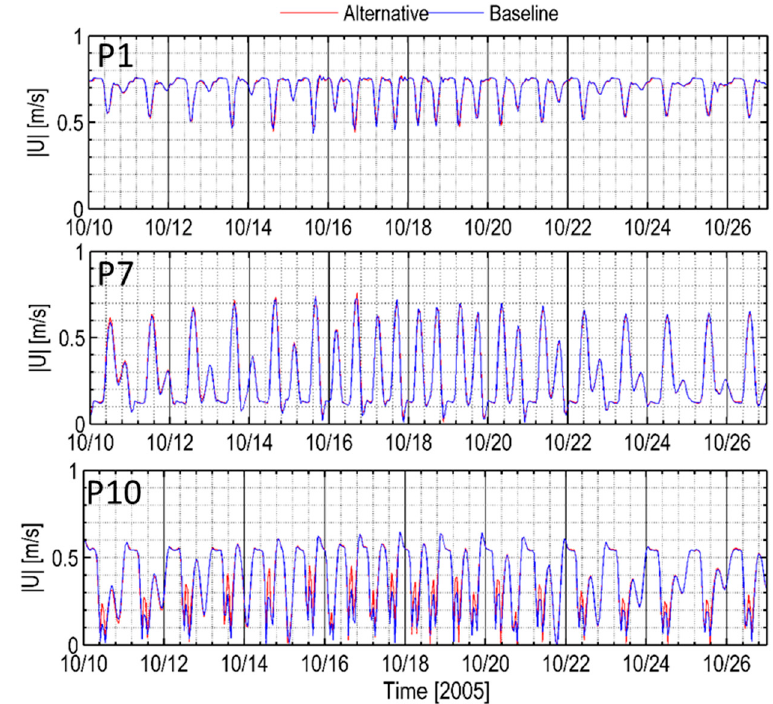
Figure 15. Preferred vs. baseline scenarios: time series of velocity magnitude at Stations P1, P7, and P10 for bank-full conditions at 750.62 m 3 /s river flow (tides and wind corresponding to October